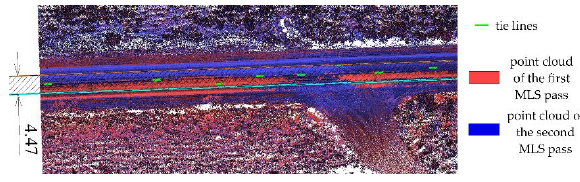
Figure 2 . MLS point clouds acquired with Riegl VMX-250: (a)